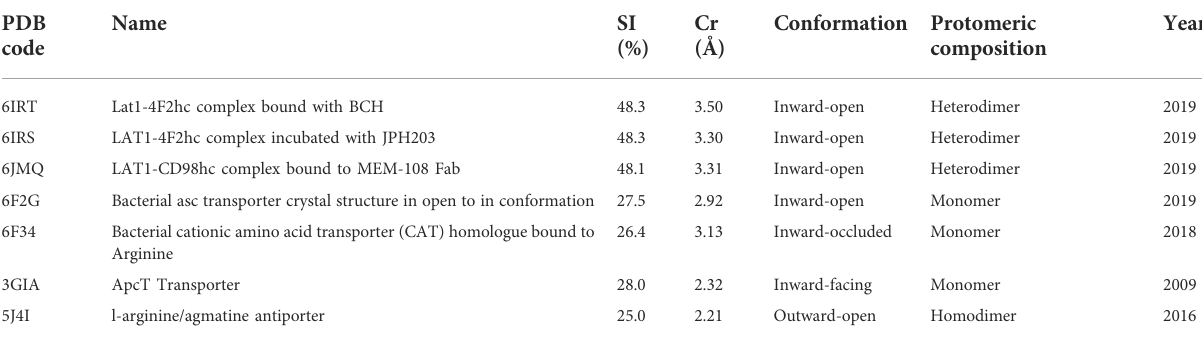
TABLE 1 Description of the studied